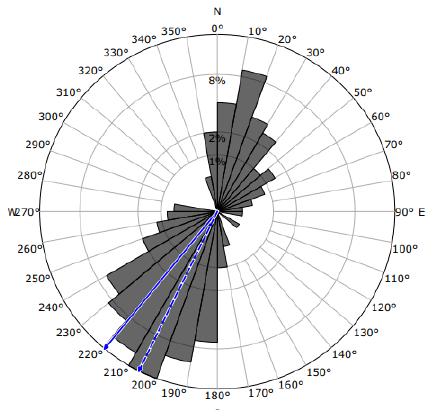
Figure 2. The orientation of the fractures during drilling over the logged interval of Well 58-32, adapted from [24], the name of the publisher: Utah Geological Survey The orientations of these fractures indicate that the maximum total horizontal stress ( σ Hmax ) trends NNE-SSW. The rose diagram shows the fracture azimuth (i.e., planar strike orientation), with the average (solid arrow) and mode (dashed arrow) of the azimuths indicated.